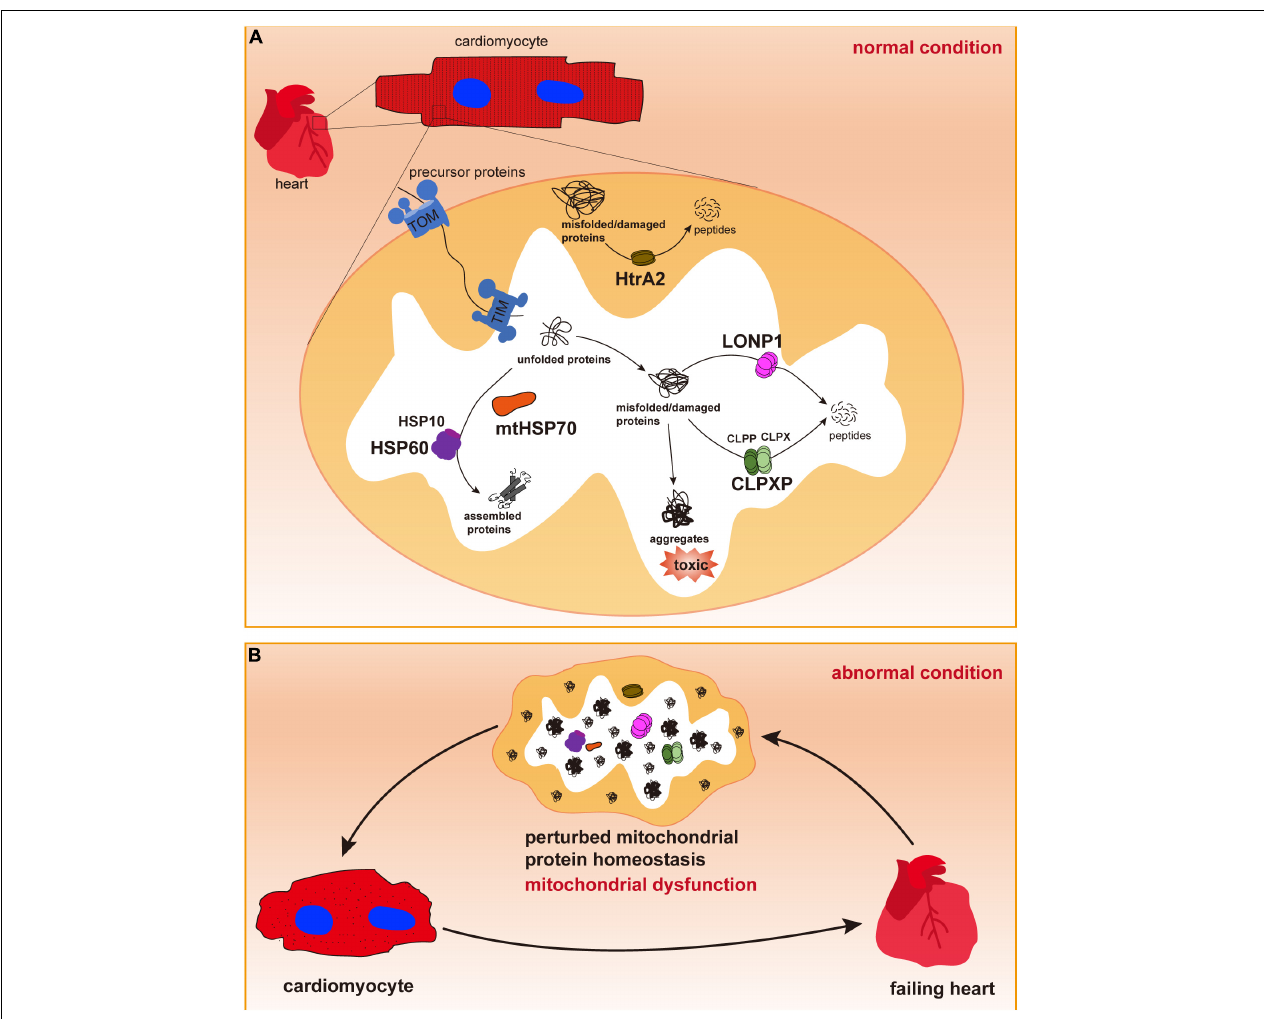
FIGURE 1 | Mitochondrial chaperones and proteases in cardiomyocytes. (A) Cardiac cells contain a large number of mitochondria, in which most proteins are synthesized in the cytosol and imported through the outer and inner membranes via TOM and TIM complexes. In the mitochondrial matrix, newly imported and unfolded proteins are folded and assembled to their functional conformations with the assistance of mitochondrial chaperones mtHSP70 and the HSP60/HSP10 complex. Misfolded or damaged proteins are degraded by mitochondrial proteases LONP1, CLPP/CLPX complex in the mitochondrial matrix or by HtrA2 in the intermembrane space to avoid toxic accumulation of protein aggregates. Maintenance of mitochondrial protein homeostasis is essential for normal mitochondrial function. (B) Dysregulation of mitochondrial chaperones and proteases may cause accumulation of misfolded/damaged proteins and protein aggregates, thus leading to mitochondrial dysfunction, cardiac cell abnormalities and pathological cardiac remodeling, and heart